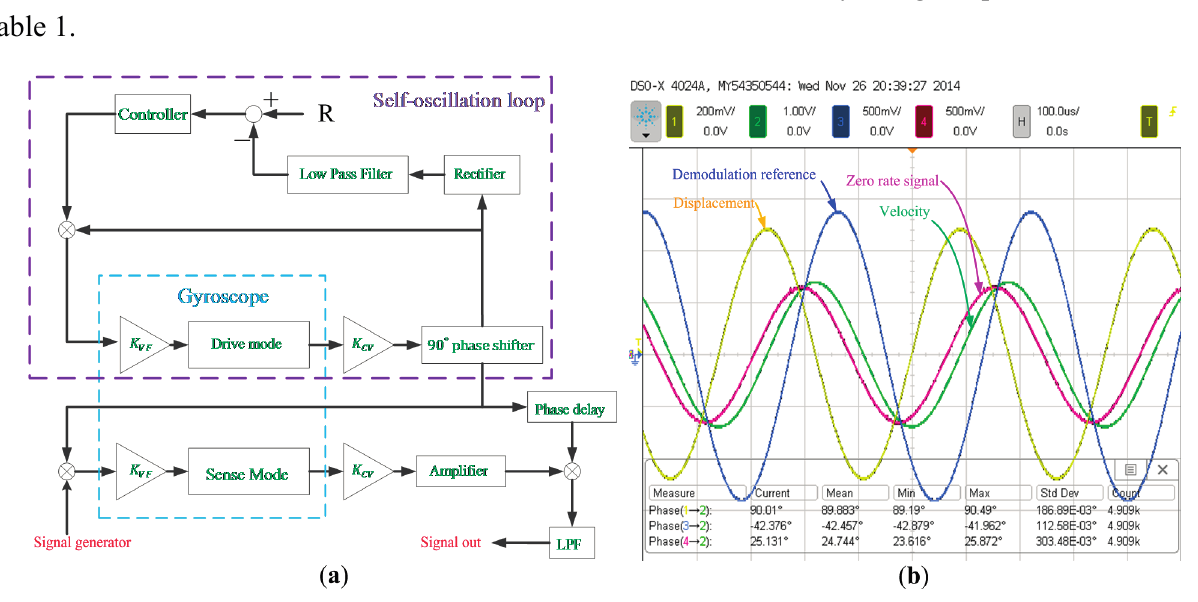
Figure 15. ( a ) The block diagram of the circuits for the bandwidth experiment; ( b ) The phase relationships of the signals in the system when no angular rate was